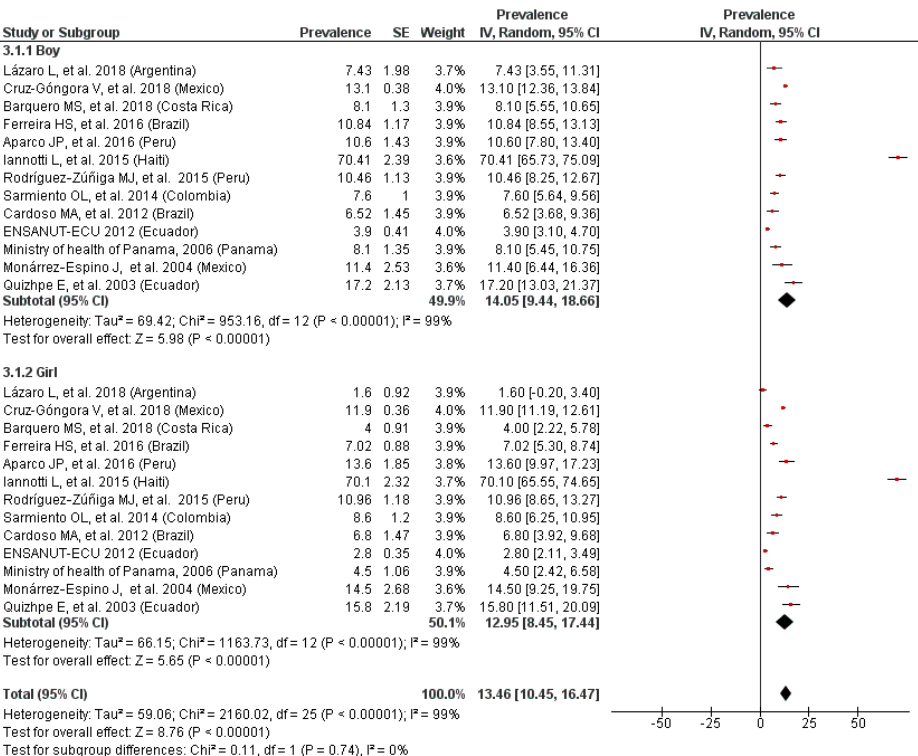
Figure 4. Prevalence of anemia in school-age children by gender.